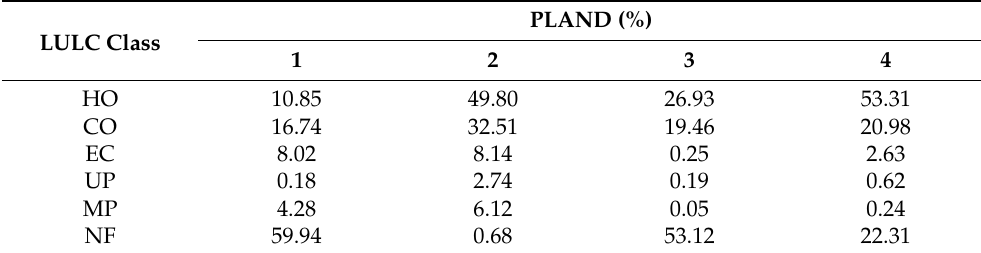
Table 7. Percentage of landscape (PLAND) per sub-region.